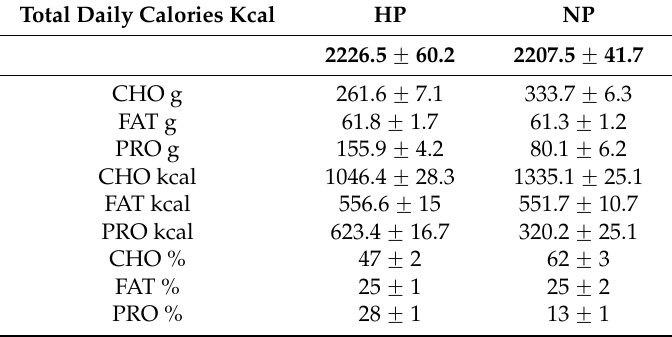
Table 1. Sample diet composition of two subjects with similar calculated daily caloric needs. The calculated individual needs are, respectively 2200 kcal/day for the HP subject and 2350 for the NP subject. The values shown in this table were based on analysis of the food